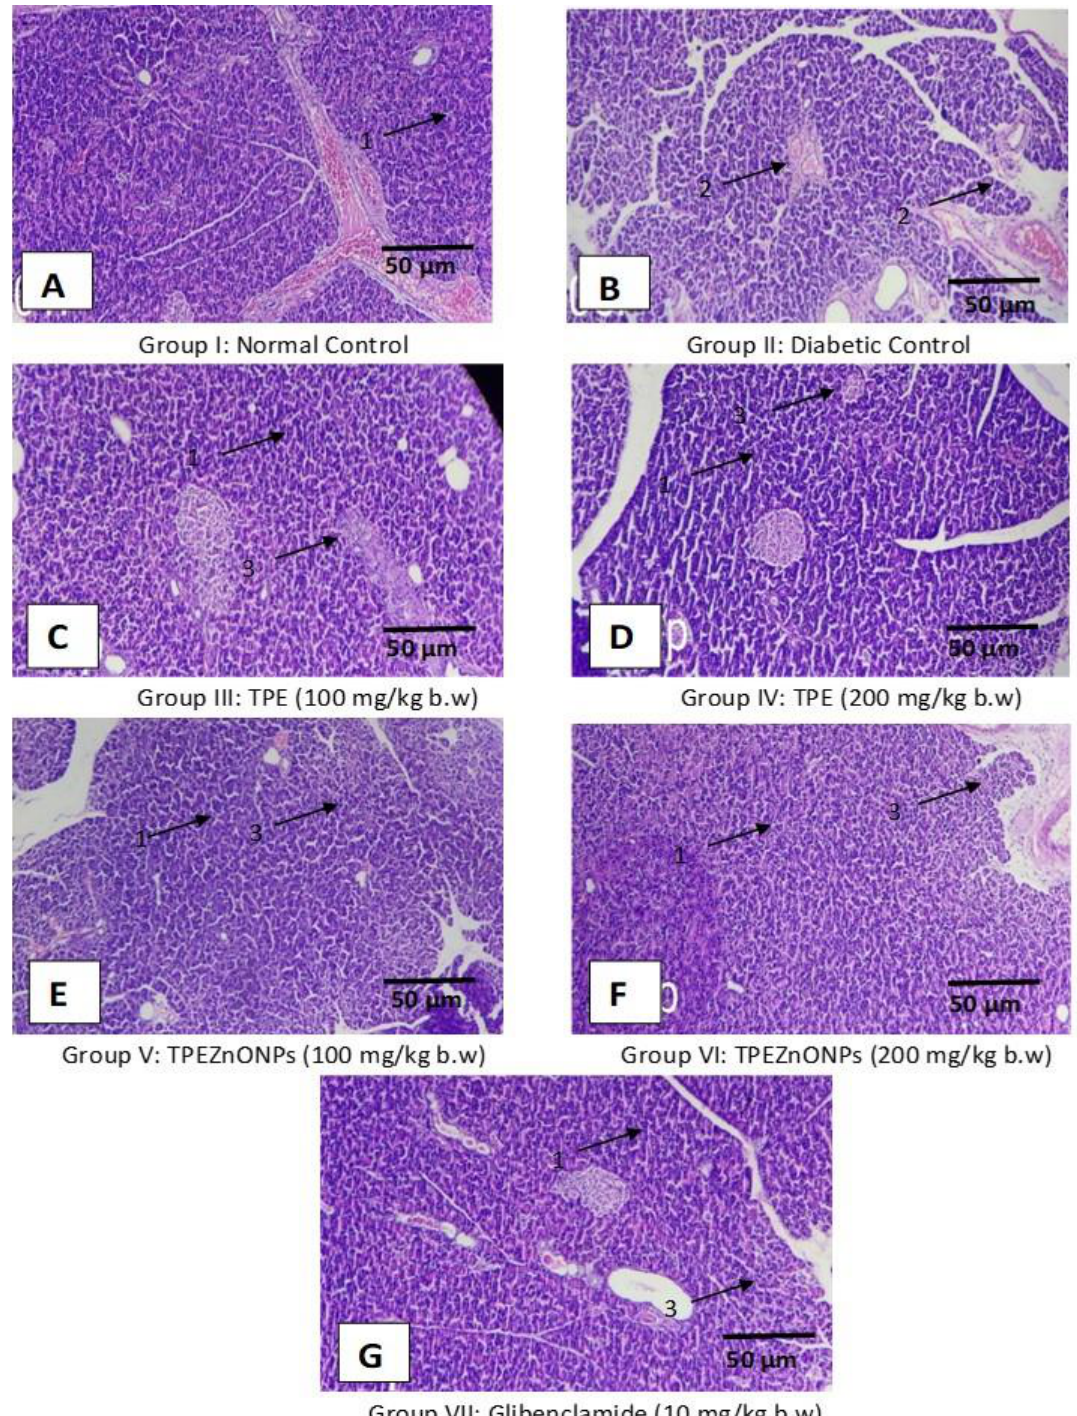
Figure 11. The pancreatic section of histology stained with hematoxylin and eosin (Scale bar 50 μm, 100× magnification).( A ) Group I: Normal control, ( B ) Group II: Diabetic control (received STZ), ( C ) Group III: TPE (100 mg/kg bw), ( D ) Group IV: TPE (200 mg/kg bw), ( E ) Group V: TPE-derived ZnO NPs (100 mg/kg bw), ( F ) Group VI: sTPE-derived ZnO NPs (200 mg/kg bw), ( G ) Group VII: Glibenclamide (10 mg/kg bw). Where 1: Beta cells Islets, 2: Depletion of beta cells, 3: Formation of Islets.